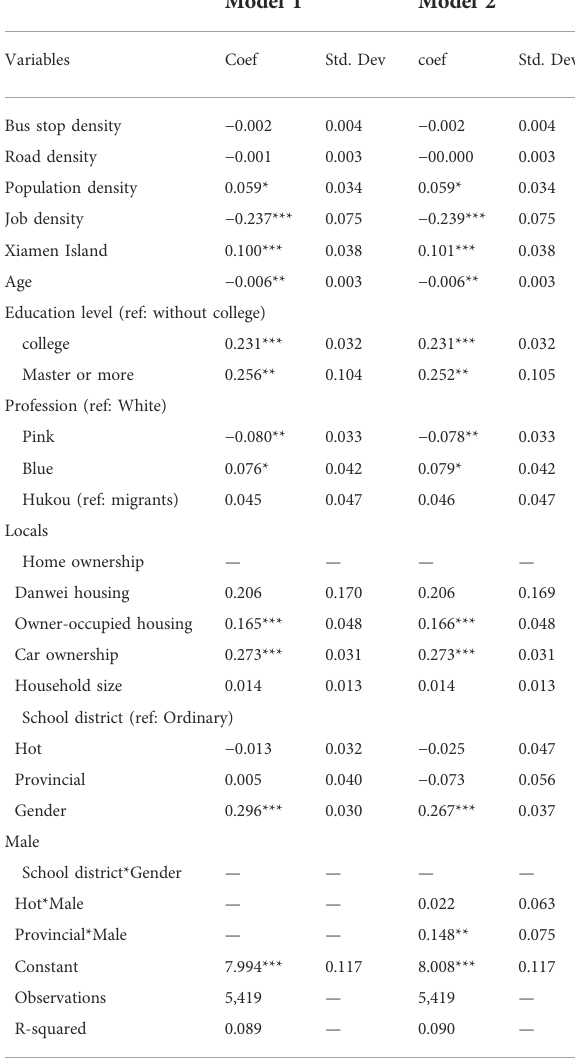
TABLE 2 Regression of the natural logarithm of commuting